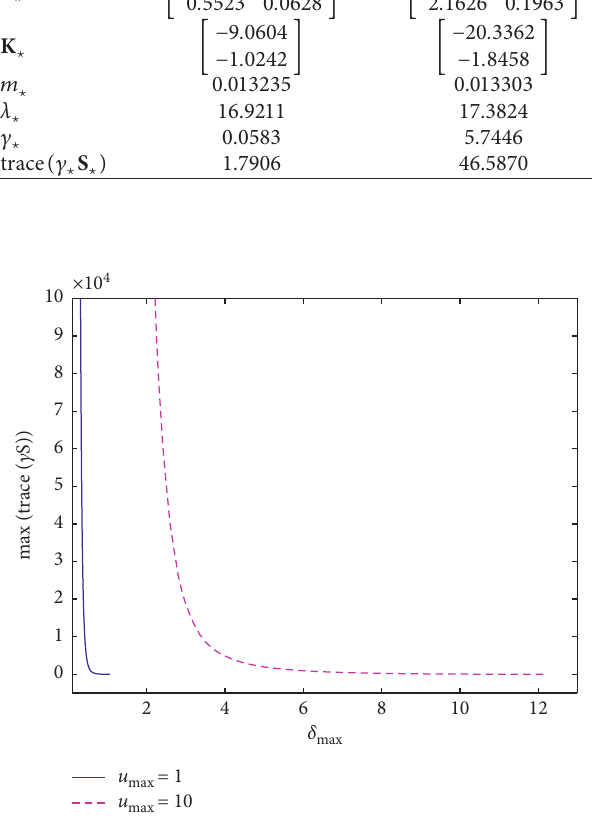
Figure 3: Variation of the size of the largest attractive invariant ( P , c ) with respect to the variation of the allowable ellipsoid ε ⋆ ⋆ ⋆ maximum bound of the parametric uncertainties for the two cases: